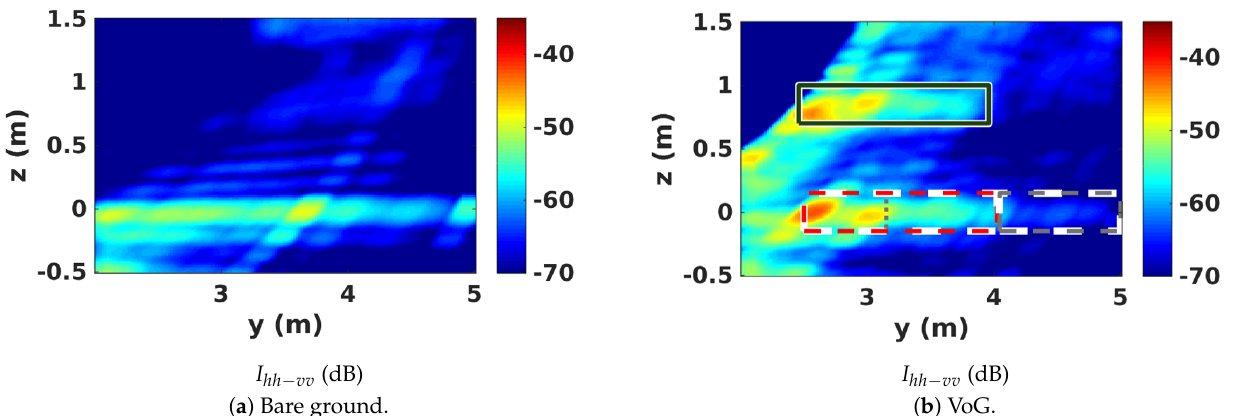
Figure 13. Tomographic profiles of bare ground and VoG in the Pauli polarimetric basis.